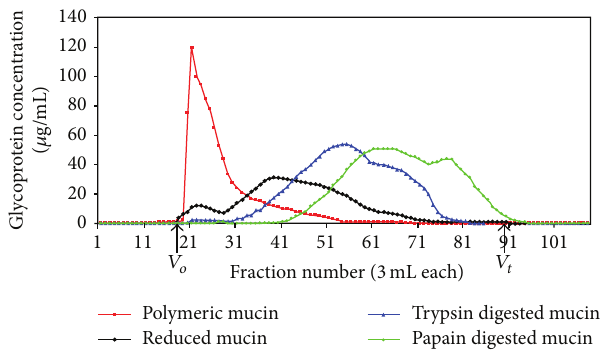
Figure 1: Chromatographic profile of the purified fractionated sinus mucin sample (S1). Sepharose CL-2B gel column (125 × 2.5 cm) was eluted by upward flow with 0.2 M sodium chloride containing 0.02% (w/v) sodium azide and flow rate 18 mL/h. Calibration was firstly performed using 1%(w/v) dextran blue solution containing 0.05% (w/v) methyl orange. The glycoprotein content was estimated by the PAS solution assay. 𝑉 𝑜 and 𝑉 𝑡 are the void and total volumes,